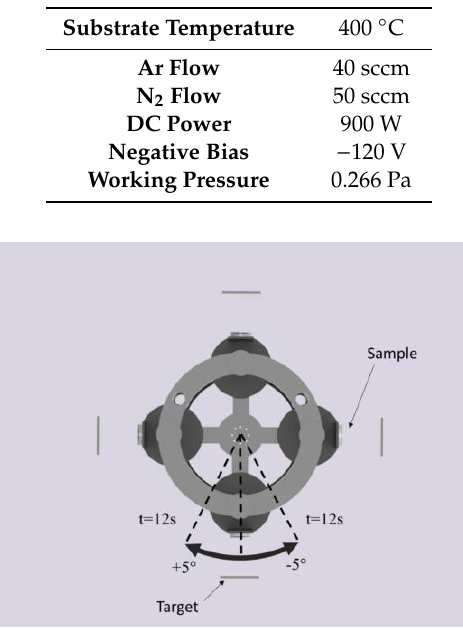
Figure 1. Schematic top view of the dynamic glancing angle deposition (DGLAD) apparatus responsible for the oscillatory motion during sputtering (not in scale). Table 1. Constant deposition parameters used to manufacture the CrN and Cr 1−x Al x N ceramic coatings.